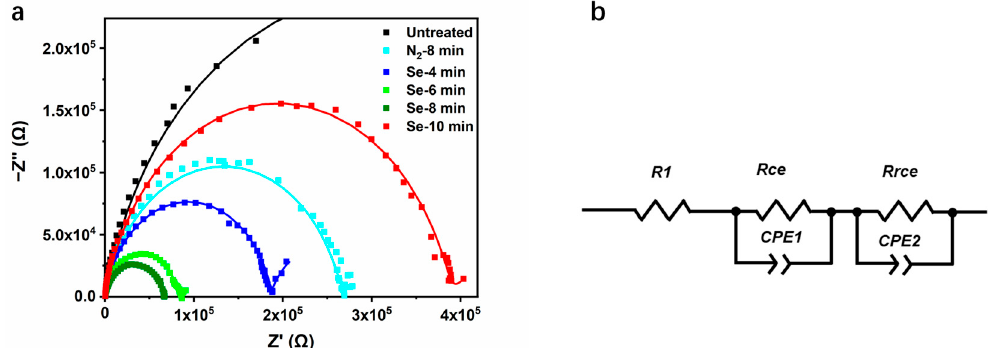
Figure 4. ESI analysis: ( a ) Cole–Cole plots and ( b ) equivalent circuit model of CuSbS 2 and CuSbS 2 (Se) devices. The solid lines represent the fitted results. Table 2. Calculation parameters from the fitted impedance spectra. Circuit Element